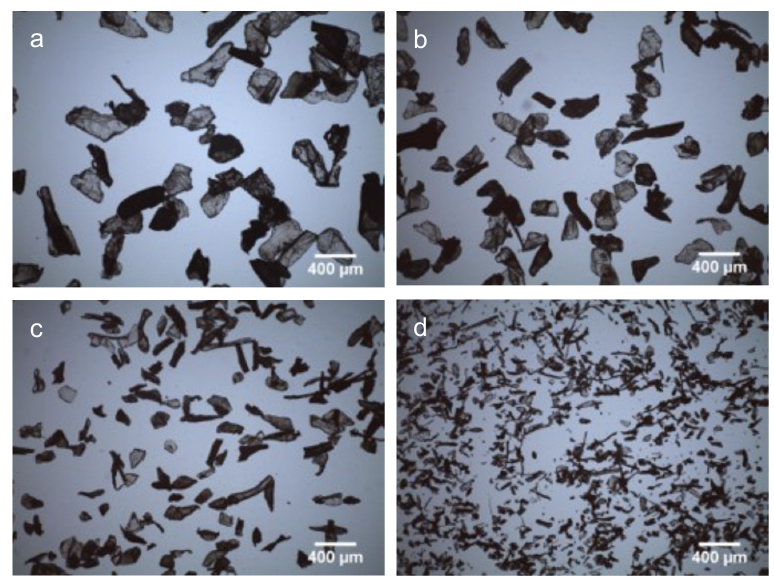
Figure 2. Optical microscopy images of CS flakes of different sizes: ( a ) 150–200 µ m, ( b ) 100–150 µ m, ( c ) 50–100 µ m and ( d ) <50 µ m.